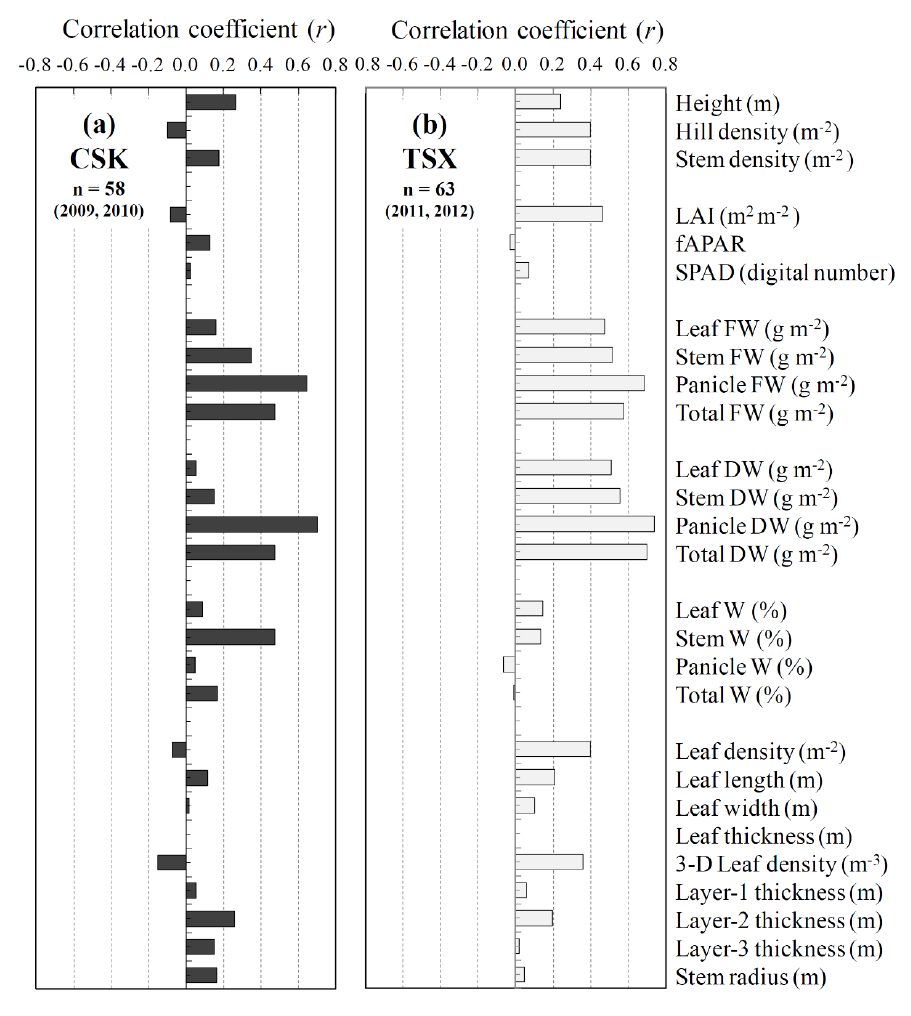
Figure 5. Correlation of σ 0 from CSK ( a ) and TSX ( b ) sensors with biophysical and morphological variables in rice canopies at maturing stage. SPAD: chlorophyll index by SPAD502; FW: fresh biomass; DW: dry biomass; W: water content; Layer-1, 2, 3: thickness of layers for panicles (1), leaves (2), and stems (3), respectively. The correlation coefficient ( r ) at significance level of 0.01 and 0.05 is 0.33 and 0.25,